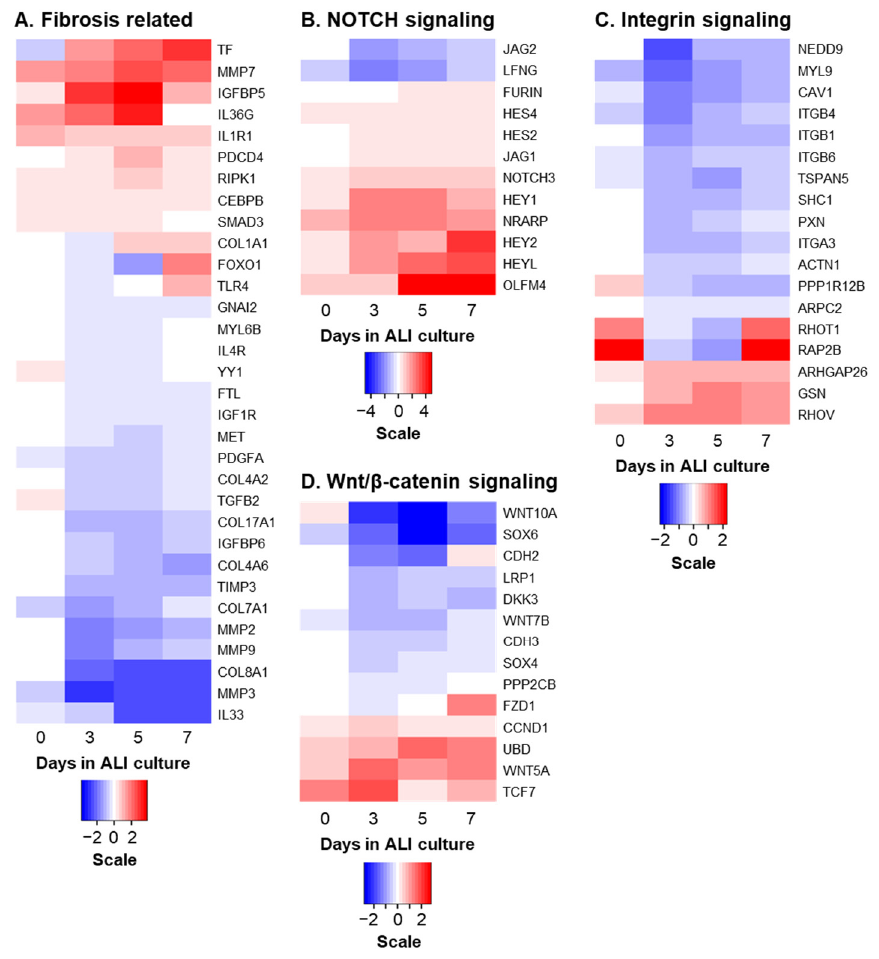
Figure 2. Activation of NOTCH3 signaling regulates expression of multiple downstream genes. Heatmaps showing temporal expression change of example NICD3-responsive genes identified by bulk RNA-seq between Lenti-NICD3 vs. Lenti-Control infected cells as a function of time after infection on ALI culture (see Figure 1 for details). The differentially expressed genes have been grouped based on biological function. ( A ) Fibrosis related. ( B ) NOTCH signaling. ( C ) Integrin signaling. ( D ) Wnt/ β -catenin signaling. Scale bar represents log 2 fold change in expression in Lenti-NICD3 vs. Lenti-Control infected